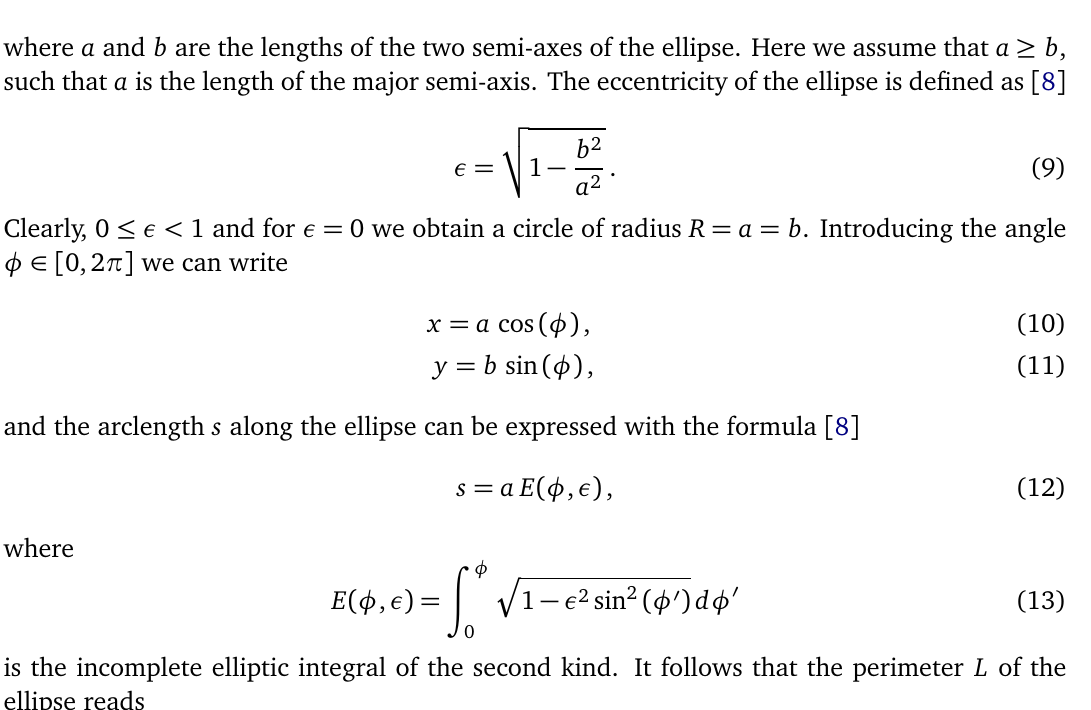
Figure 1: Quantum-curvature potential U vature κ ( s ) of an ellipse, as a function of the arclength s , where a is the length of the major semi-axis, L = aE ( 2 π , ε ) is the perimeter of the ellipse, and E characteristic energy. The curves are obtained for different values of the eccentricity ε